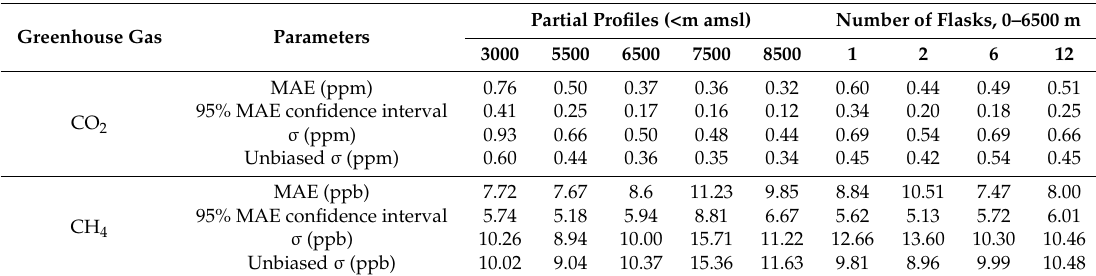
Table 1. Error statistics for total column CO 2 (XCO 2 ) and CH 4 (XCH 4 ) based on simulated partial profiles and flask sampling given as mean absolute error (MAE; ppm), standard deviation from the true value (AirCore derived total column), and standard deviation in an “unbiased scenario” where the XCO 2 mean of synthetic profile and the true value are the same. The confidence interval was derived from two-tailed t